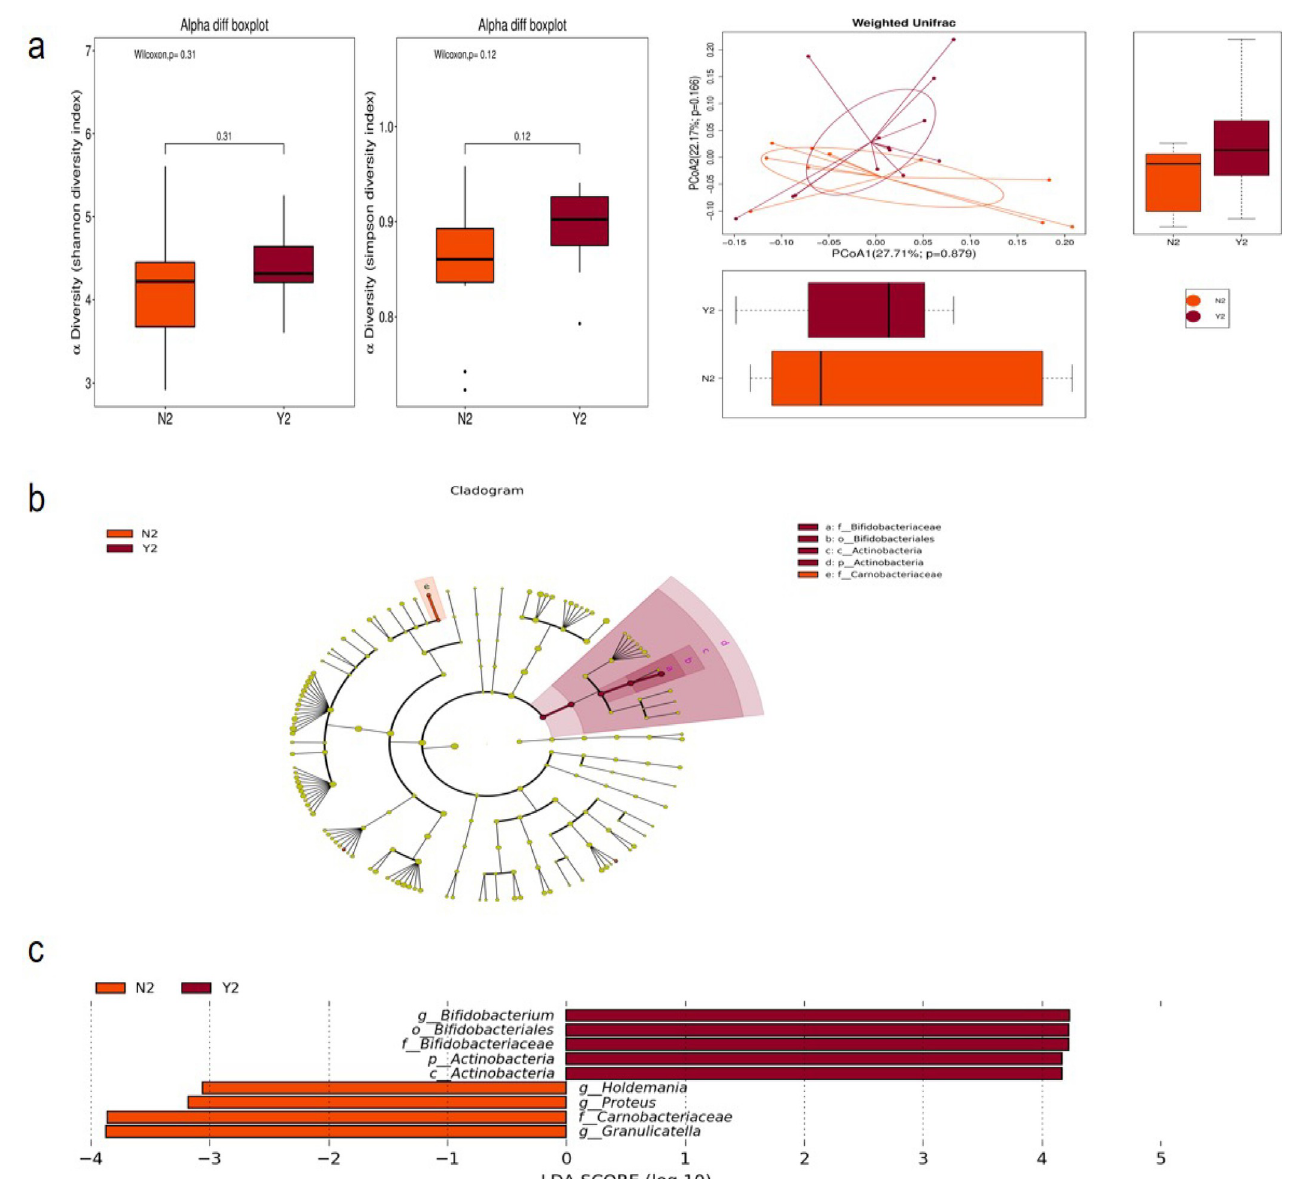
Fig 5. Comparison of gut microbiome in pregnant women with GDM after MNT. (a). Alpha diversity between the effective group and the ineffective group after the therapy; beta diversity between the effective group and the ineffective group after the therapy: Weighted Unifrac distance; (b-c). LEfSe outcome between the effective group and the ineffective group after the